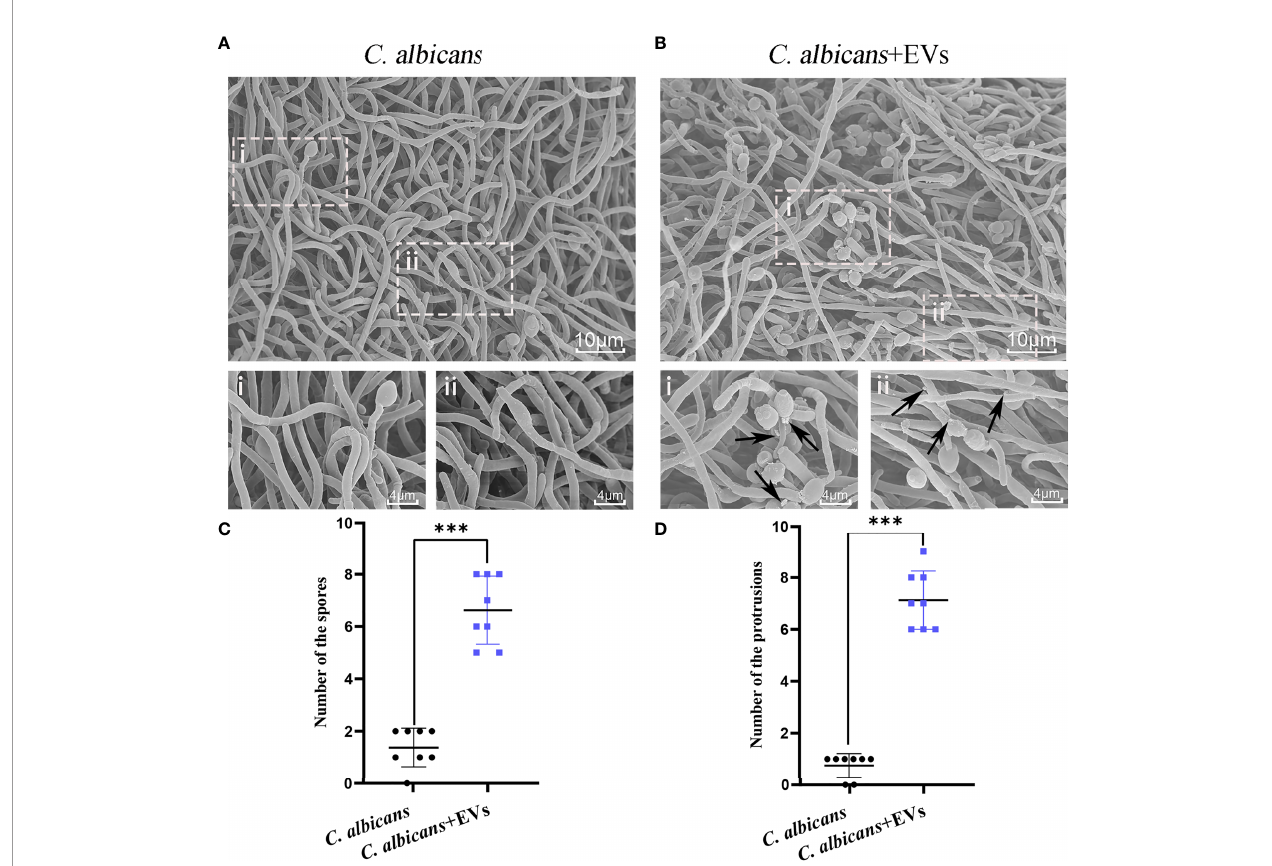
FIGURE 4 | SEM analysis of C. albicans . (A) Representative SEM images of the C. albicans group. (B) Representative SEM images of C. albicans treated with Leuk- 1-EVs for 12h. Images with increased magni fi cation are shown below and indicated with i or ii. In the treatment group, more spores were found, and protrusions appeared on hyphae. These speci fi c changes are indicated by black arrows in (B) . The scale bar of the upper row represents 10 m m. The scale bar of the bottom row represents 4 m m. (C) Changes in the spore number of different groups at 12 h. The C. albicans + EVs group has signi fi cantly more spores than the C. albicans group. (D) Changes in the hyphal protrusion number of different groups at 12h. The C. albicans + EVs group has signi fi cantly more protrusions than the C. albicans group. Statistical signi fi cance was tested by Mann-Whitney U test. ***P <